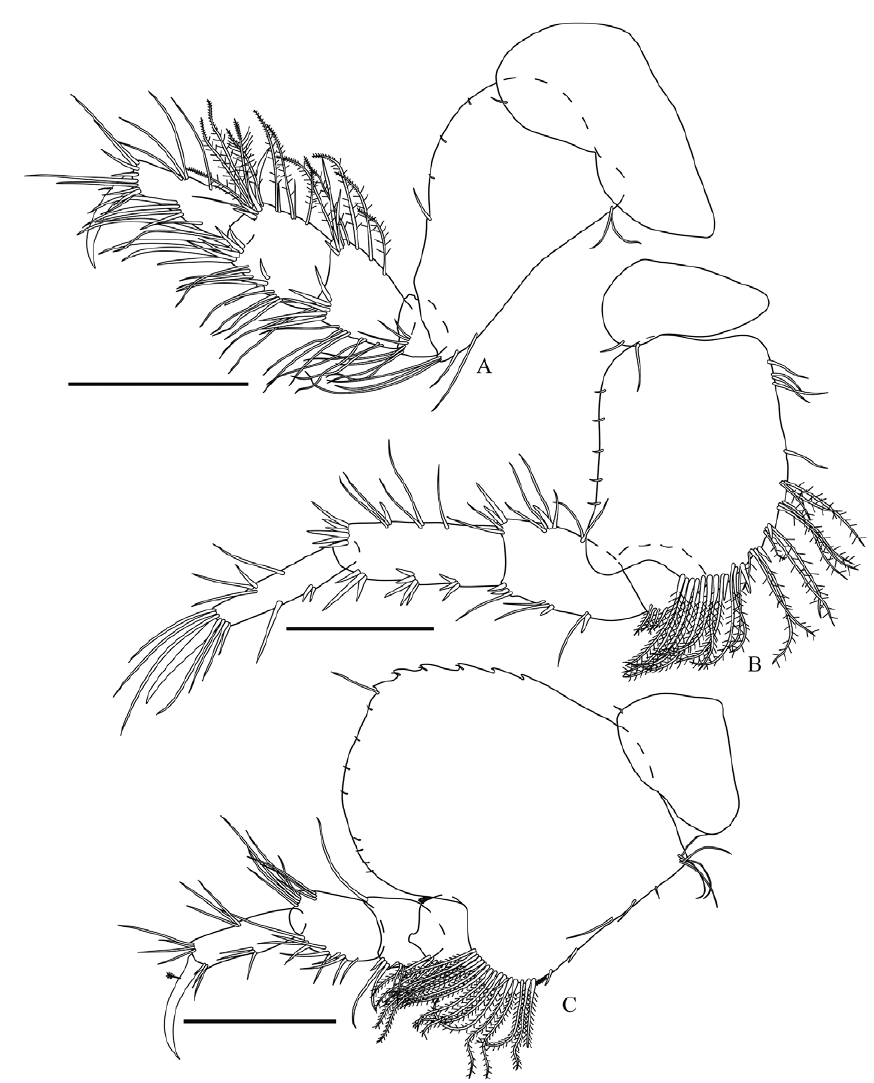
Fig. 4. – Atlantiphoxus wajapi n. sp. holotype female (UERJ 401). A, pereopod 5; B, pereopod 6; C, pereopod 7. Scale bars: 0.5 1 seta medially; ischium small and sub-rectangular, facial margin with row of 5 setae extending to an- terodistal corner; merus anterior margin moderately setose, with a row of 5 setae distally, posterior margin with 5 papposerrate and 5 stout setae; carpus facial setal formula: 3-5-4-3, anterior margin with 8 long setae, posterior margin with papposerrate and simple setae; propodus anterior and posterior margins weak- ly setose, distal apex with 9 setae; dactylus elongate, about 70% the length of propodus. Pereopod 6 (Fig. 4B) coxa sub-rounded, posteroventral margin weakly posterior margin moderately setose; carpus posterior expanded, with 2 setae; basis about 1.2× longer than margin moderately setose, with 1 thicker stout seta wide, anterior margin with long plumose and stout distally, almost reaching half of dactylus; propodus setae medially, anterodistal corner with a row of 8 anterior margin with 1 short seta distally, posterior long plumose setae, posterior margin with setules; margin with 4 long setae; dactylus stout, about 75% ischium small and subquadrate, anterior margin with the length of propodus. Pereopod 5 (Fig. 4A) coxa 4 plumose setae; merus anterior margin with 4 stout bilobate, posteroventral margin weakly expanded, and 4 long setae, posterior margin with 3 stout and with 1 short seta; basis about 1.4× longer than wide, 8 long setae; carpus facial setal formula: 3-5-3-6, strongly tapering distally, anterior margin with 2 se- posterior margin with 1 stout and 5 long setae; pro- tae proximally and 5 distally, posterior margin with podus anterior margin with 1 long and 2 stout setae,